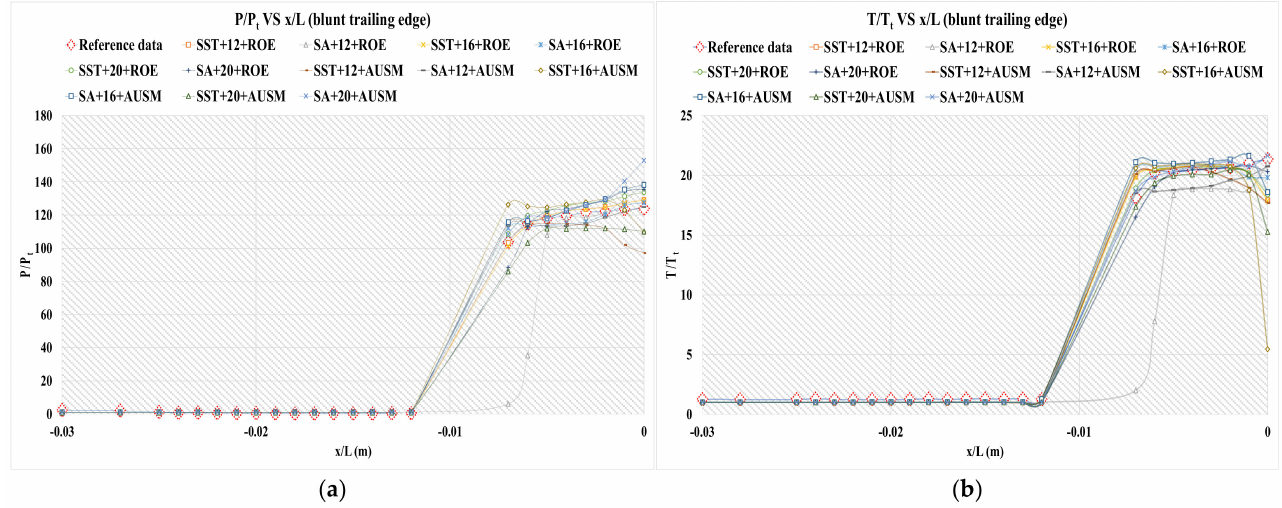
Figure 5. ( a ) Distributions of P/P t of the blunt trailing edge; ( b ) Distributions of T/T t of the blunt trailing